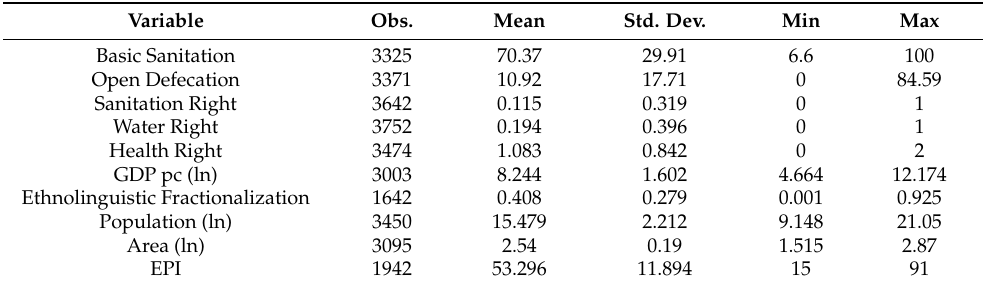
Table 2. Descriptive Statistics.